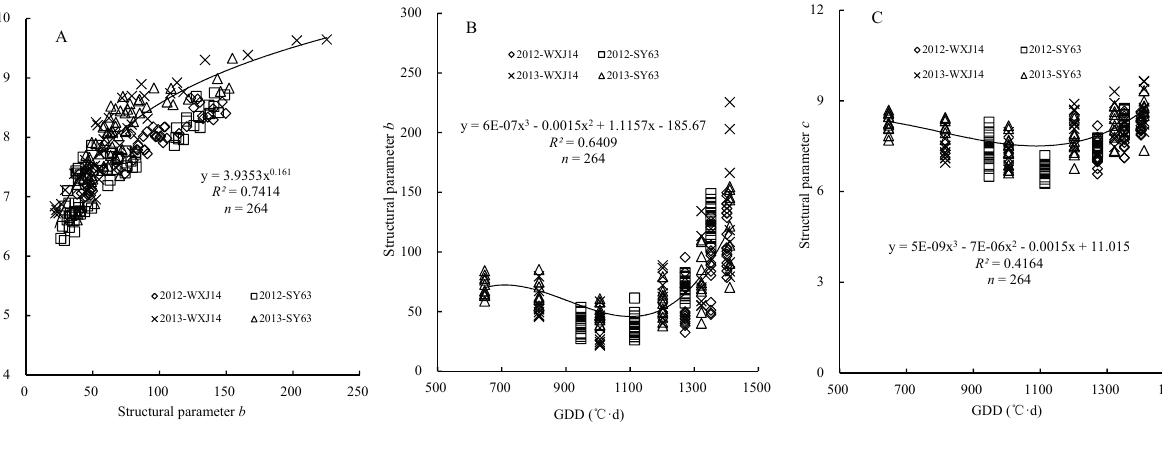
Figure 4. Relationship between rice canopy structure parameters b and c ( A ), growing degree days ( GDD ) and b ( B ), c ( C